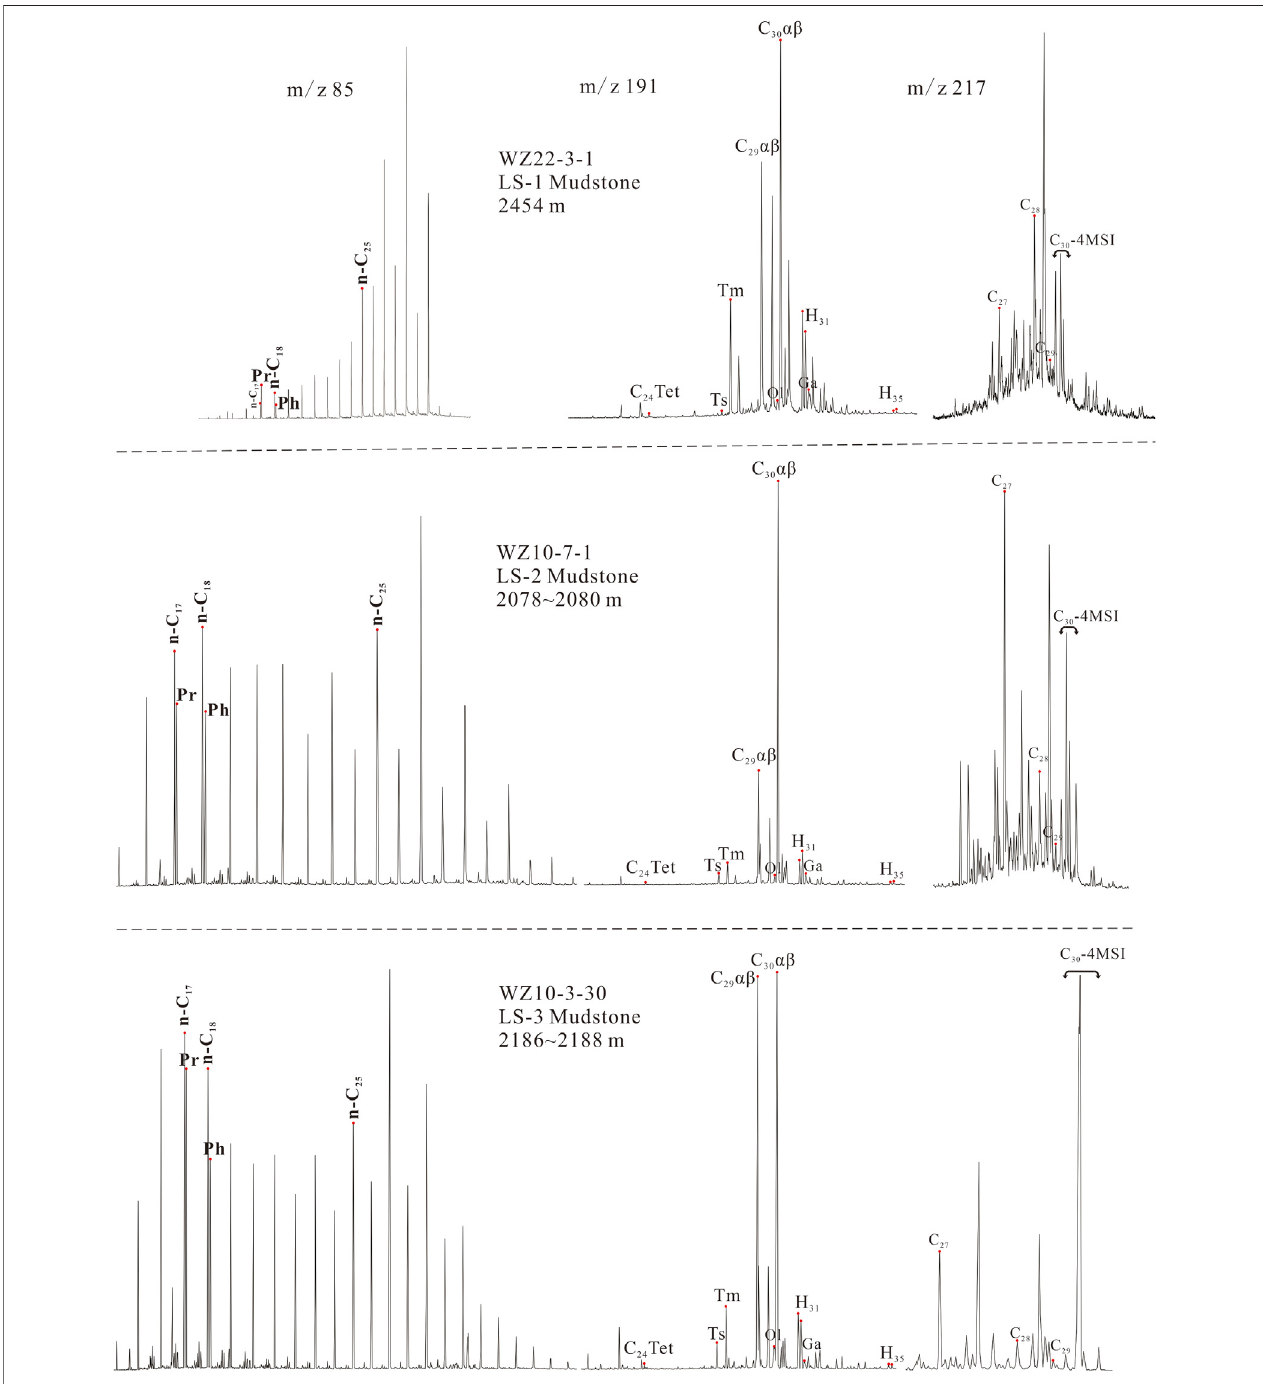
FIGURE 4 | Representative n -alkane (m/z 85), hopane (m/z 191), and sterane (m/z 217) mass chromatograms for the source rocks from the fi rst (LS-1), second (LS-2) and third (LS-3) member of the Liushagang Formation. C 27 , C 28 and C 29 = C 27 , C 28 and C 29 ααα 20R steranes; C 30 -4MSI = C 30 4-methylsteranes. The symbolic meanings of other compounds can be found in Table 2 .